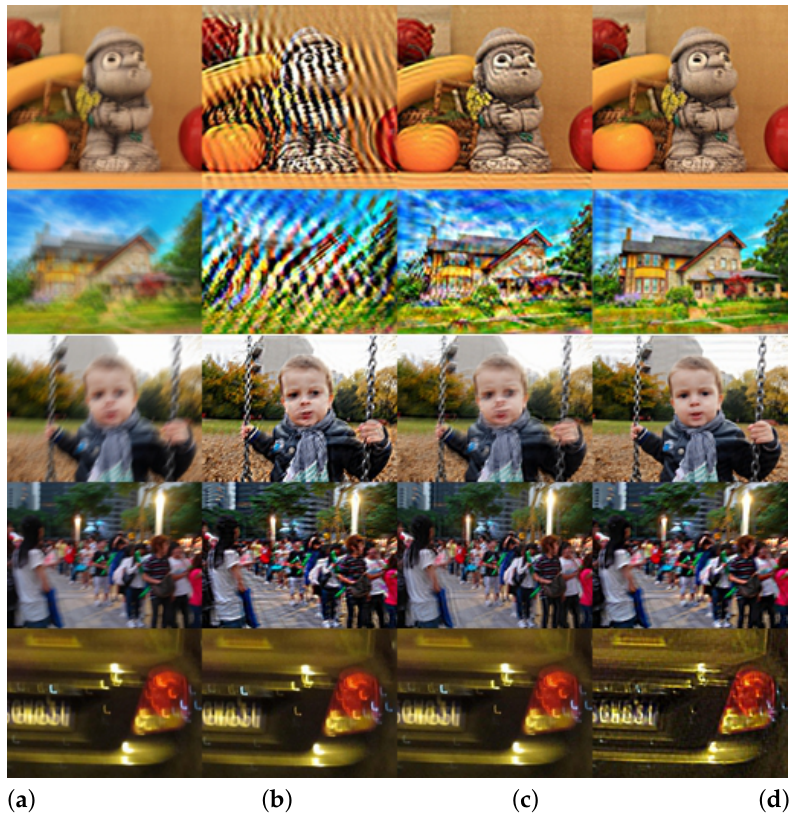
Figure 12. Deblurring results on some challenging examples. ( a ) Blurry inputs. ( b – d ) Deblurring results generated by Ref. [18], Ref. [19] and our method,